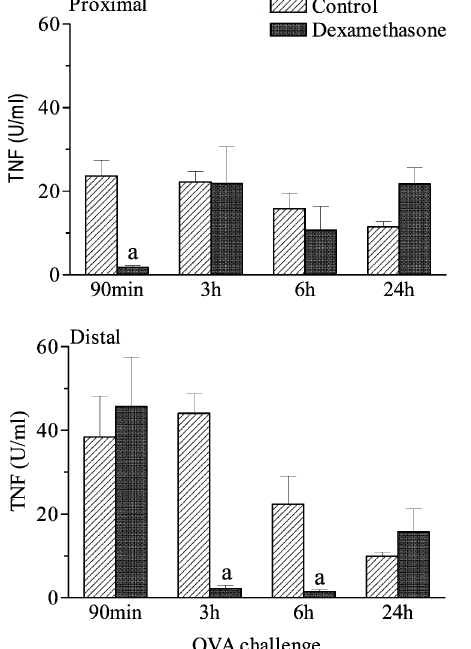
FIG. 4. Effect of invivotreatment with dexamethasone (1 mg/ kg intraperitoneally) on the TNF- a activity in supernatants from proximal (upper panel) and distal (lower panel) tracheal segments submitted to OVA challenge. Procedures as in Fig. 2. Data represent mean 9 / standard error of the mean from five to 10 experiments. a, p B / 0.05 in comparison with the respective control